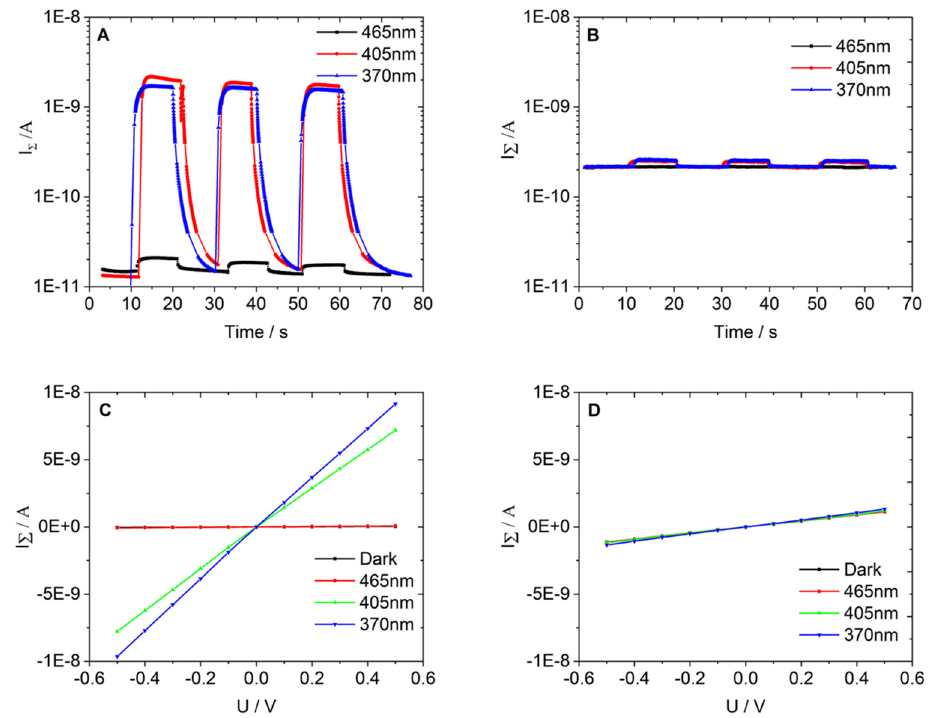
Figure 6. Semi-logarithmic plot of the transient photocurrent responses of Spikelet ( A ) and P25 ( B ) layers under periodic illumination by 465, 405 and 370 nm with 2 mW·cm − 2 intensity LED. ( C , D ) I Σ -U characteristics Spikelet and P25 films in dark and illuminated conditions. Table 1. Results of DC electrical measurements for TiO 2 Spikelet layer.